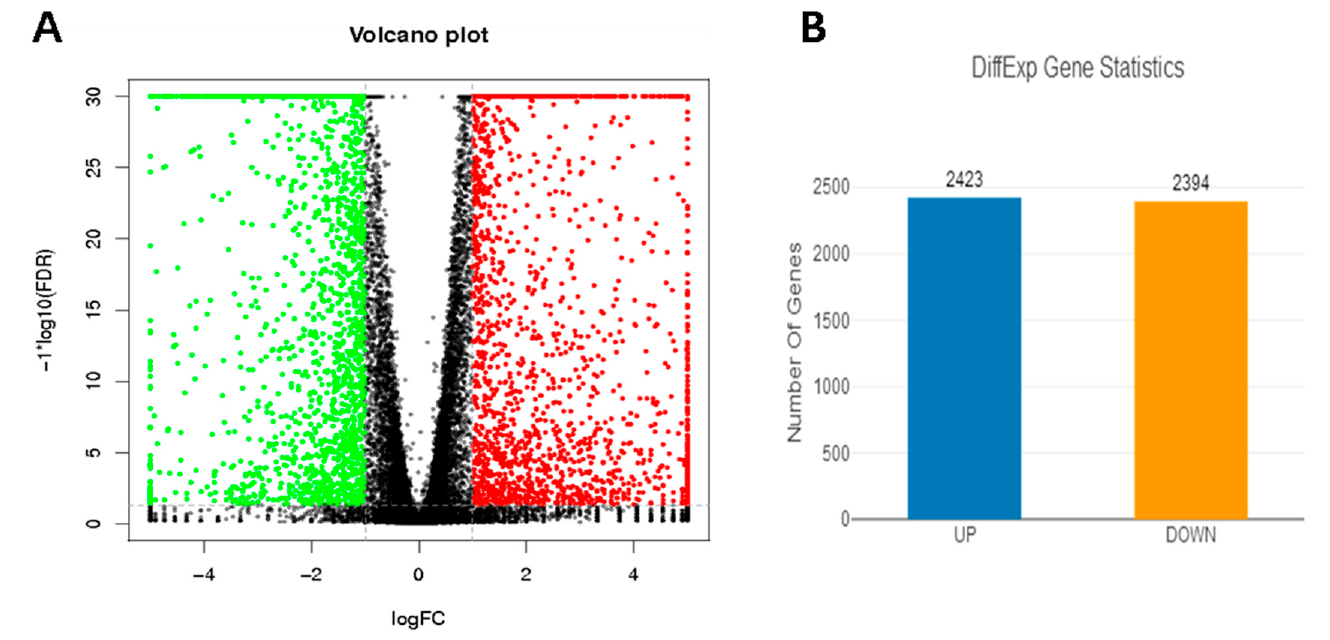
Figure 7. The identification of differentially expressed genes (DEGs). ( A ) DEGs with higher (H) and lower (L) levels are displayed on the volcano plot. Genes that differ significantly are represented by red and green points, respectively, with a fold change |log 2 FC| >1 and FDR < 0.05. Genes with a fold change |log 2 FC| ≤ 1 and no significant difference are represented by black points; red and green points denote up-regulated and down-regulated genes, respectively. ( B ) Higher (H) and lower (L) levels of DEG statistics. Down-regulated and up-regulated genes are represented on the X -axis, while the number of DEGs is represented on the Y -axis.